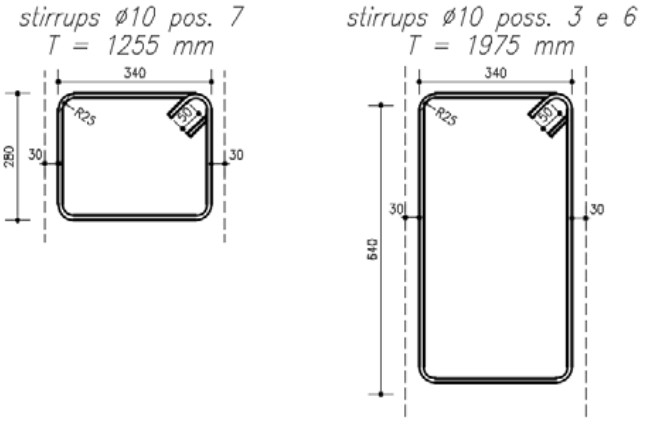
Figure 8. Rebars in pos. 3, pos. 6, and pos. 7.